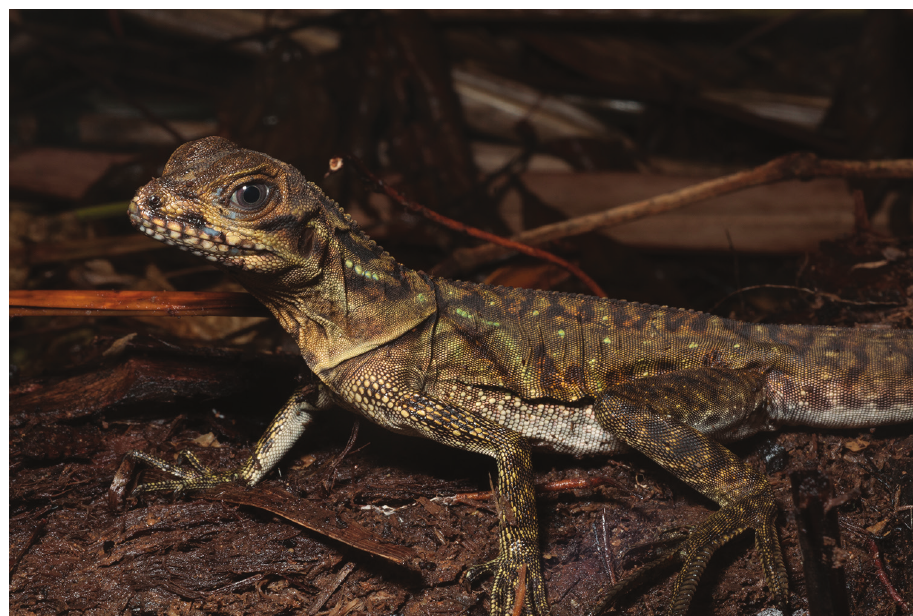
Figure 44. Hydrosaurus pustulatus , the widespread Sailfin Lizard has been recorded at numerous sites in Agusan del Norte and Misamis Oriental Provinces; the species is also known from Caminguin Sur Island. Photo: RMB (from the Municipality of Burauen, Leyte Island; specimen deposited at